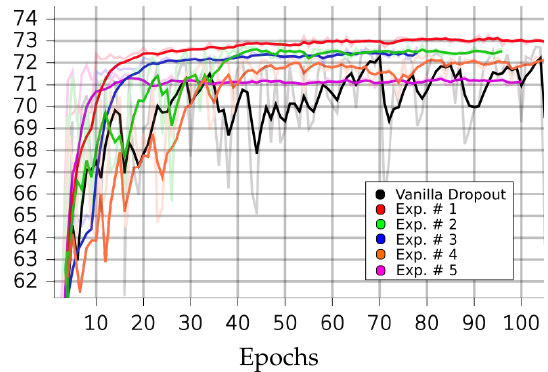
Figure 4. Performances of LIM and vanilla dropout methods on the CIFAR10 dataset, trained and tested for 100 epochs. Graphs were smoothed for better comprehension; original graphs can be seen in the background. Curves correspond to Table 2 scores. Black: vanilla. Red: 1. Green: 2. Blue: 3. Orange: 4. Purple: